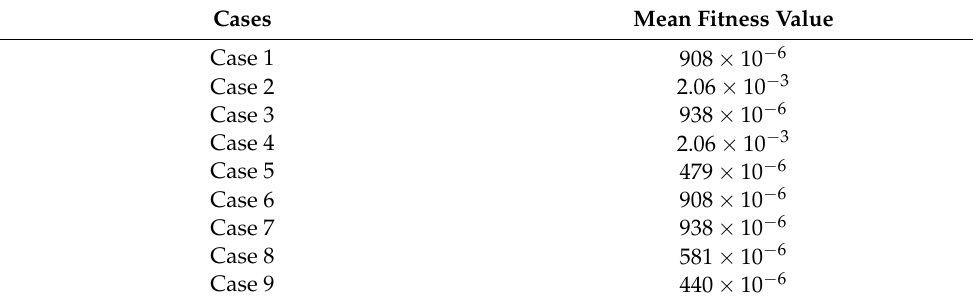
The fitness plots for case 9 with zero noise for three generations and populations are shown in Figures 3 and 4. The fitness curves with fixed generation size and varying population size are given in Figure 3a–c, and Figure 4a–c include fitness curves for the fixed population size and changing generation size. Figures 3 and 4 show that with the best parameter setting of β = 0.1 and µ = 0.1, the AO strategy achieves minimum fit for a large number of generations and populations.